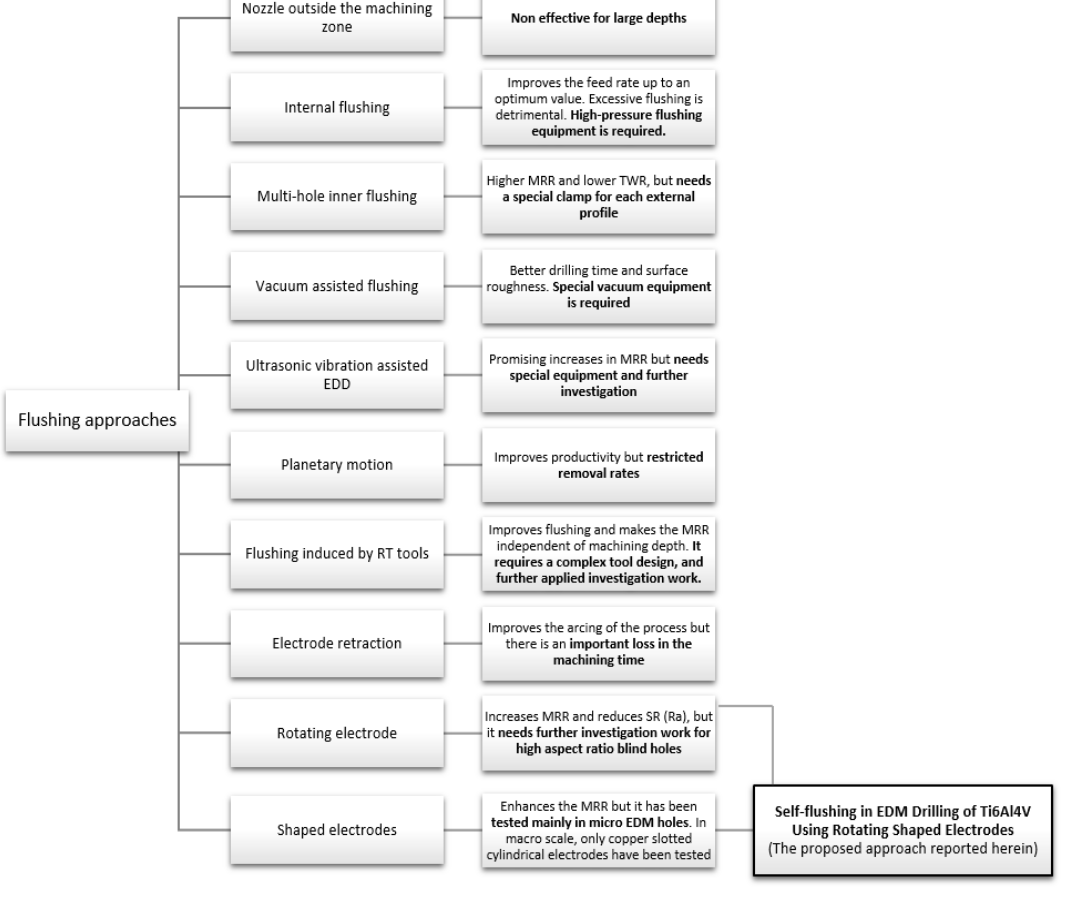
Figure 1. An overview of the state-of-the-art flushing techniques in the Electrical Discharge Machining (EDM) process and the positioning of this research work within the context of the reported literature.